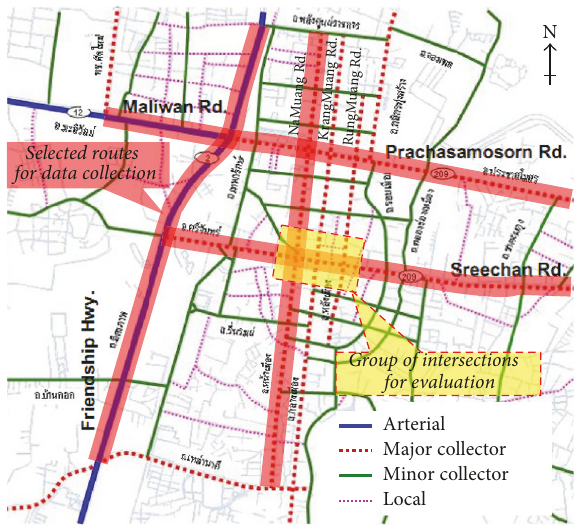
Figure 4: Selected routes for data collection and a group of intersections for